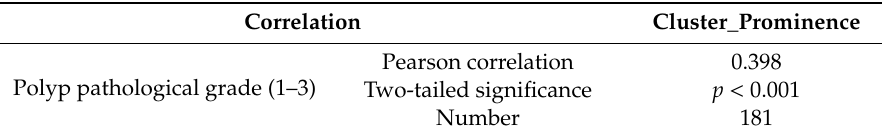
Table 3. Association of cluster_prominence with pathological